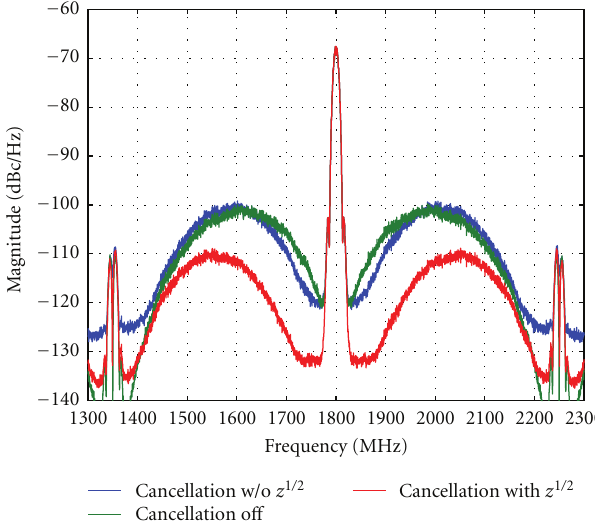
Figure 7: The simulated PSD of a GFSK-modulated signal showing PQN cancellation obtained with and without T s / 2